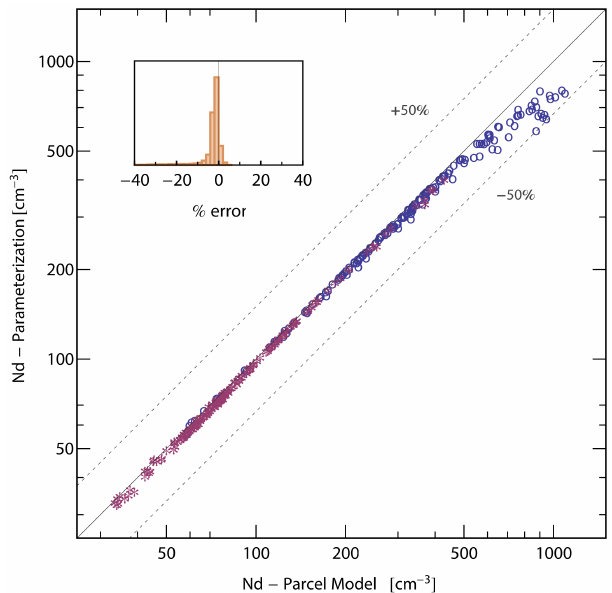
Figure 3. Comparison between parcel-model simulations and parameterization results. Blue circles correspond to continen- tal aerosol, while red stars are for marine aerosol. The inset is a histogram of the relative error between parcel model and parameterization-derived N d